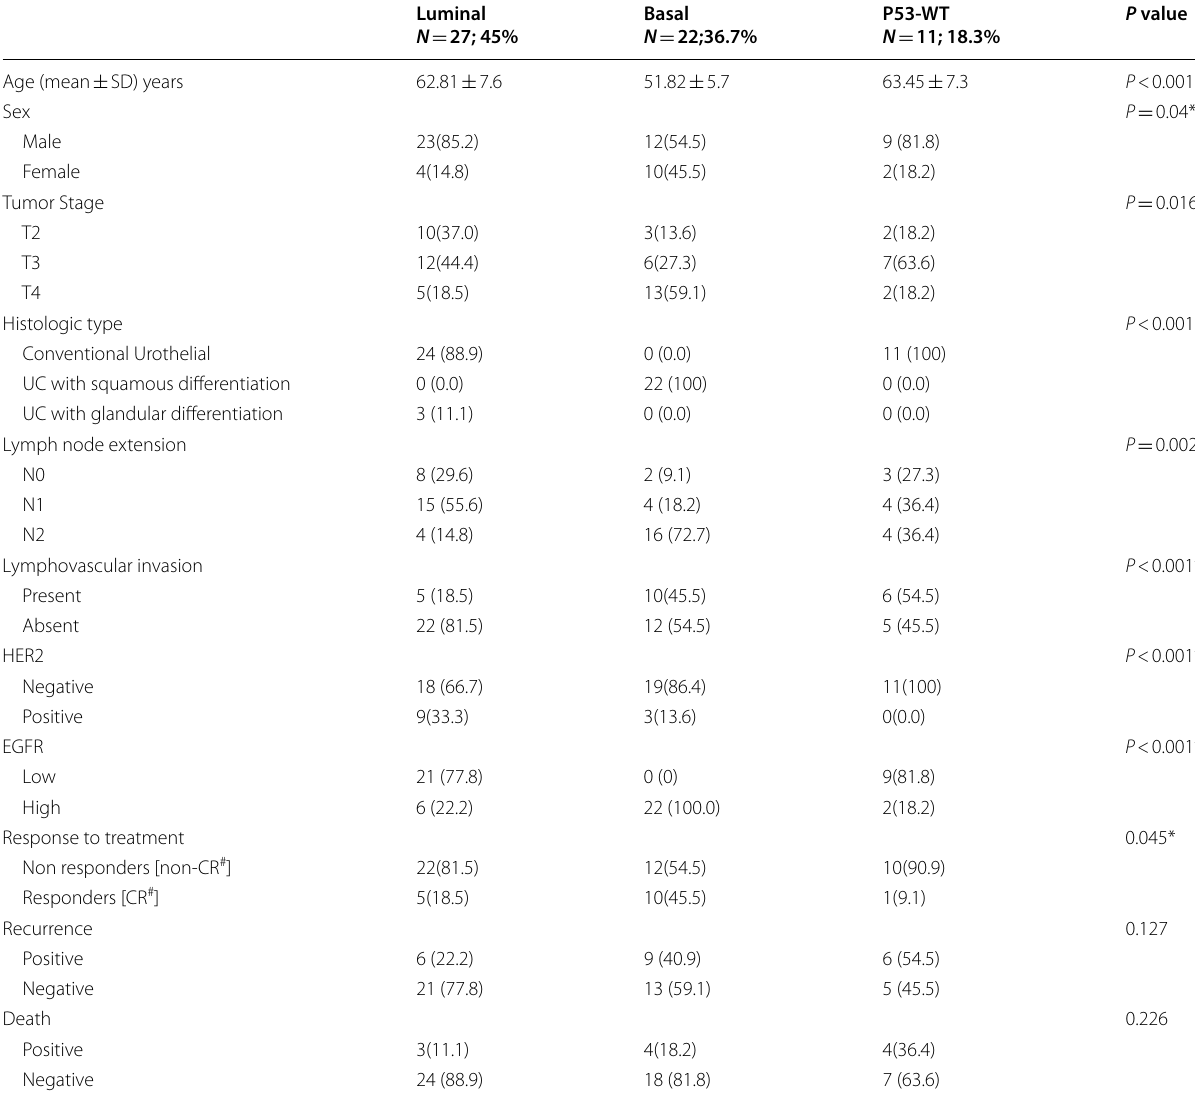
Table 3 Relation between molecular subtype and clinicopathologic characteristics of MIBC studied